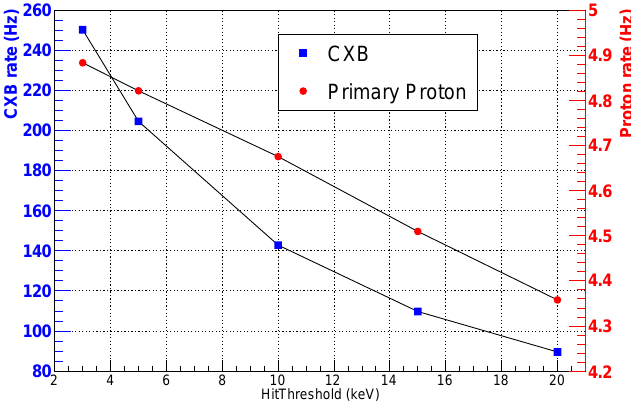
Figure 6. Two-hit event rates of CXB and primary protons, as a function of hit